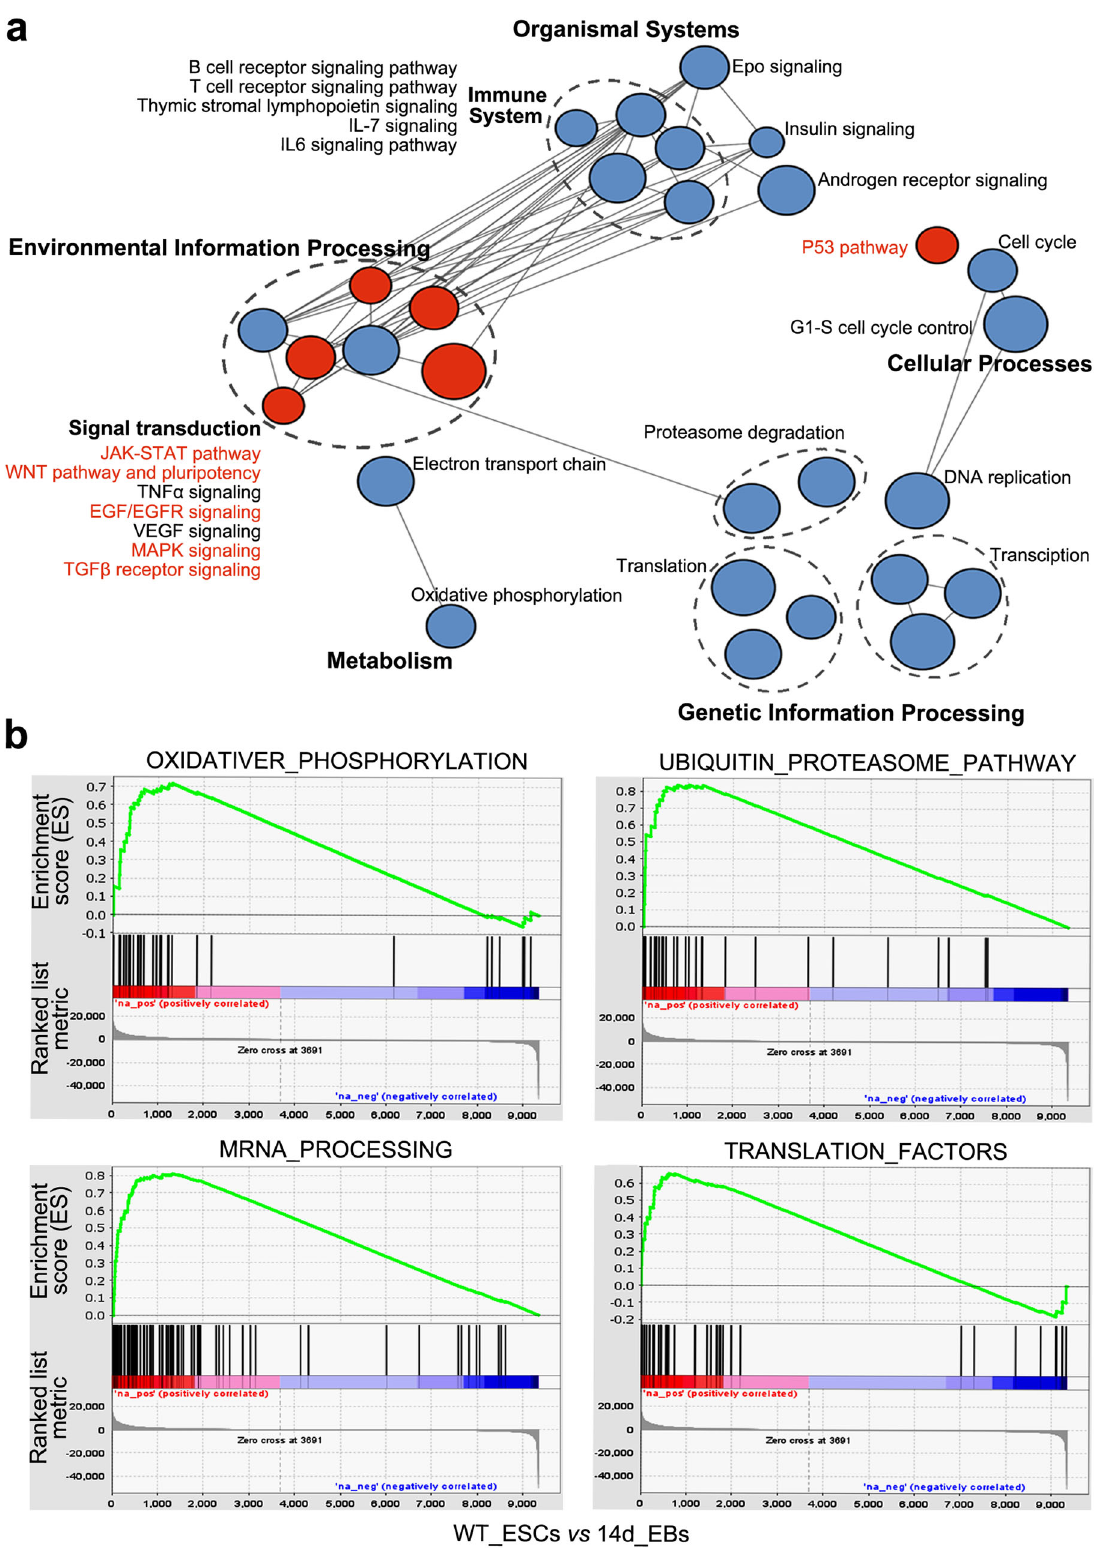
Fig. 4 Enrichment analysis of the iSRGS. a Enrichment map networks of pathway terms enriched by the iSRGS. The red nodes indicate pathways that were reported to participate in pluripotency maintenance. b GSEA showed the expression of fundamental pathway genes in ESCs relative to EBs differentiated for 14